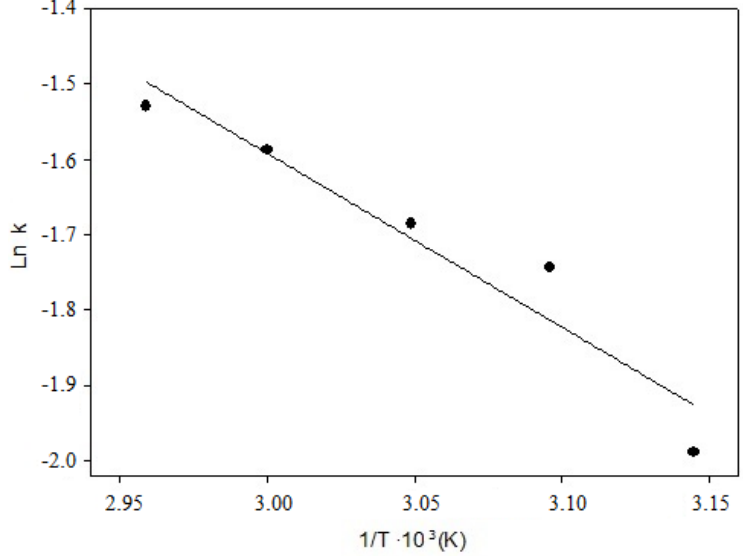
Figure 5. Arrhenius plot (Ln k vs . 1/ T ) obtained from the evolution of Ln k values with temperature, where k = viscosity −1 ; operating under standard conditions, with 12 mL of oil, 2.43 mL of methanol, 0.8 g of catalyst weight, 60 min reaction time and different reaction temperatures in the interval 25–65